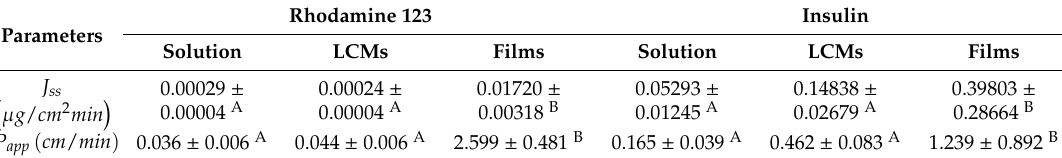
Figure 4. Cumulative ex vivo permeation profiles of insulin (Ins) in solution, loaded in lipid-core micelles (LCMs) and in LCMs-loaded on mucoadhesive films through excised porcine buccal epithelium, with phosphate bu ff er pH 6.8. Values are represented as mean ± standard deviation of five di ff erent batches ( n = 6). Table 5. Steady-state di ff usive flux ( J ss ) and apparent permeability coe ffi cient ( P app ) parameters for ex vivo permeation profiles of rhodamine 123 and insulin in solution, in lipid-core micelles (LCMs) and LCMs-loaded mucoadhesive films. Di ff erent superscript letters (A, B) in the same row and category indicates statistical di ff erences by one-way analysis of variance with Tukey’s multiple comparison tests ( p <